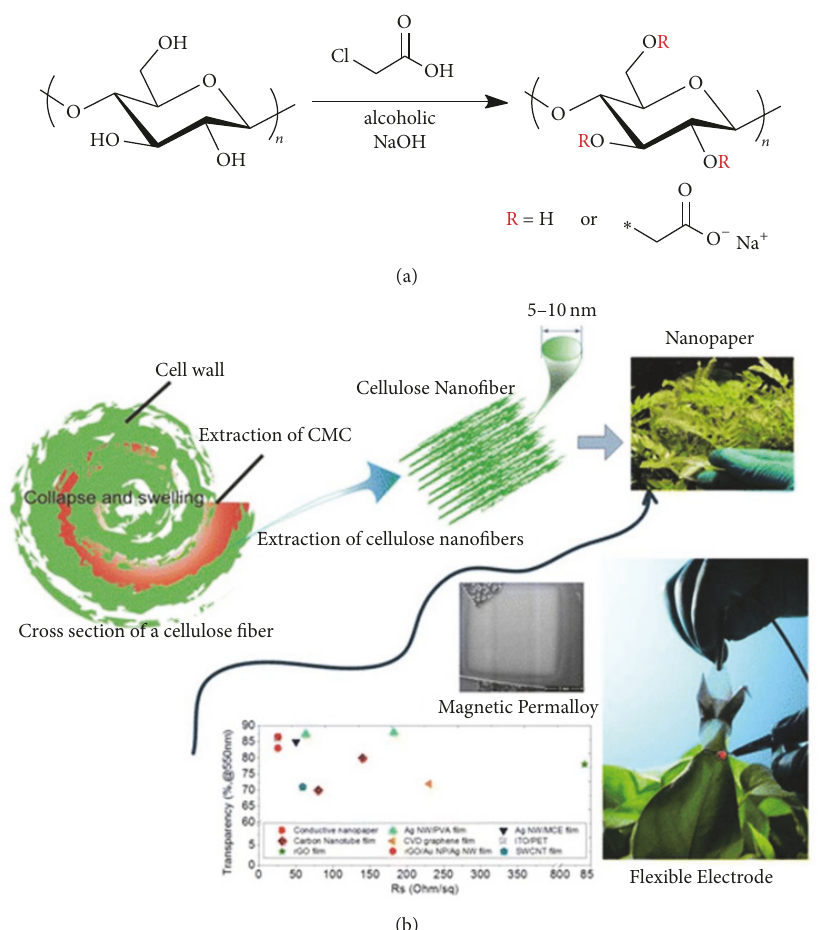
Figure 14: Schematic diagrams of (a) chemical formula for carboxymethylation of cellulose by using chloroacetic acid and (b) carboxymethylation pretreatment of cellulose for the preparation of CNFs and the application of resultant CNFs as nanopaper and flexible electrode [88].